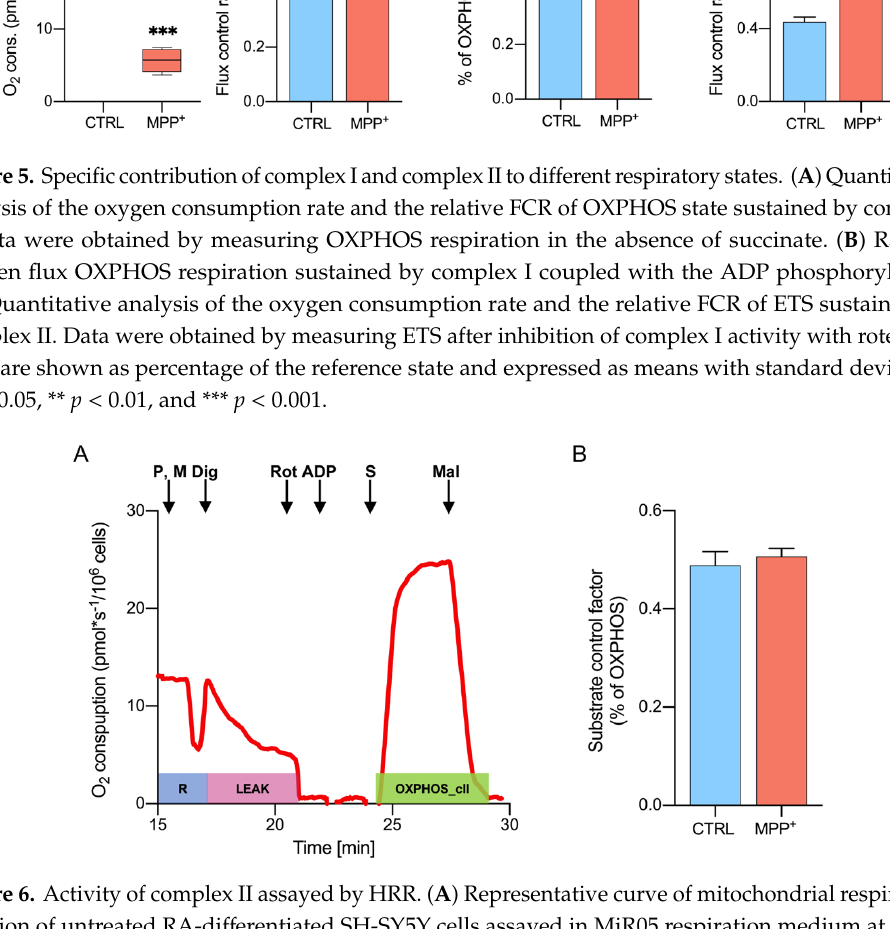
Figure 6. Activity of complex II assayed by HRR. ( A ) Representative curve of mitochondrial respiratory function of untreated RA-di ff erentiated SH-SY5Y cells assayed in MiR05 respiration medium at 37 ◦ C. The respiratory states ROUTINE, LEAK, and OXPHOS driven by complex II were obtained after the addition of specific substrates and inhibitors. P, pyruvate; M, malate; Dig, digitonin; Rot, rotenone; S, succinate; Mal, malonic acid. ( B ) Quantitative analysis of the oxygen consumption rate of control or MPP + treated cells of OXPHOS sustained by complex II. Data are expressed as the percentage of the total OXPHOS and shown as SCRs (mean with standard